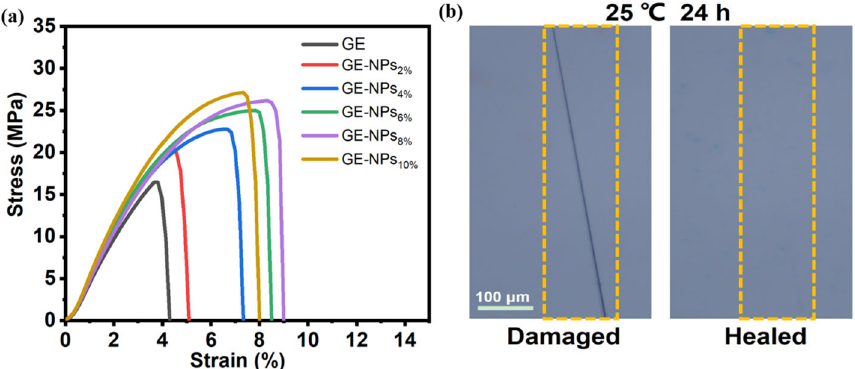
Figure 5. ( a ) Mechanical properties of the nanocomposite coatings; ( b ) The self-healing process of GE-NPs 10% coating was observed by the optical microscope.